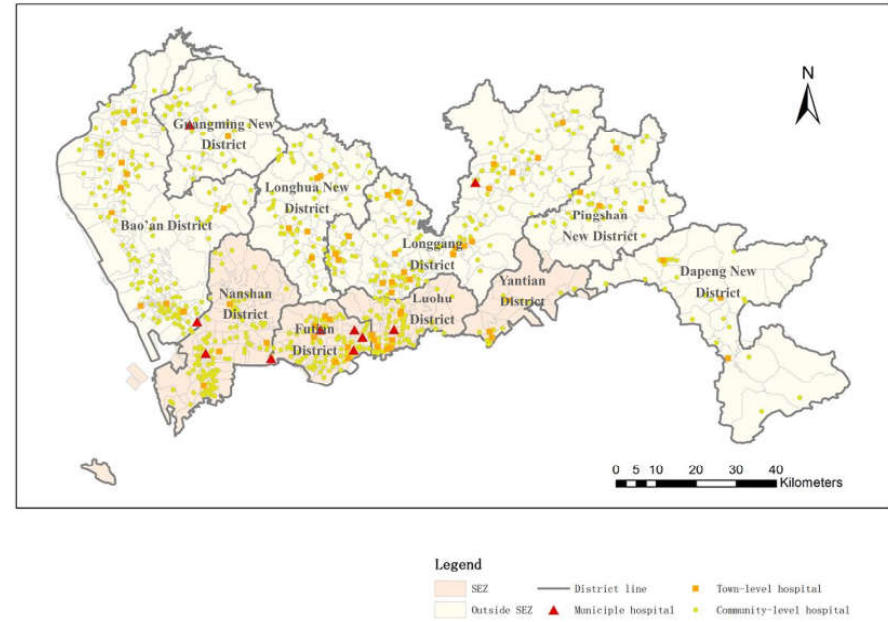
Figure 1. Spatial distribution of hospitals in Shenzhen.